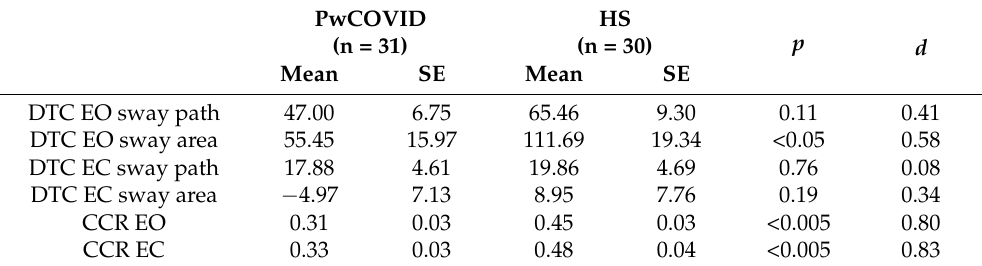
Table 2. Comparison between PwCOVID and HS in dual-task cost and correct cognitive response.